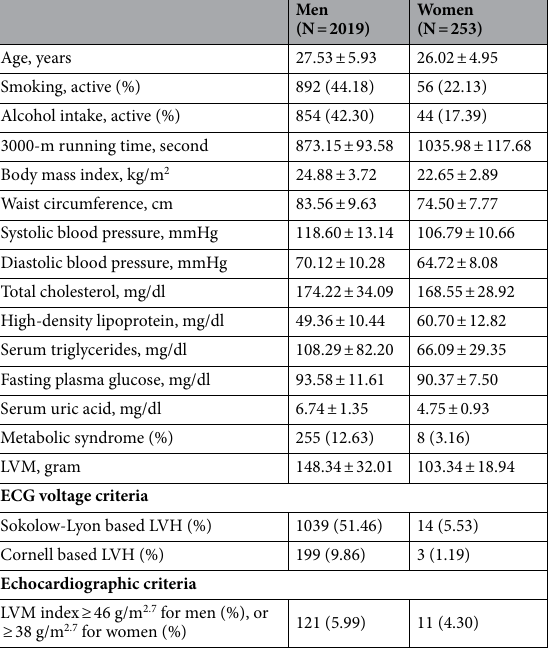
Table 1. Baseline Characteristics of the Military Men and Women (N = 2272. ECG Electrocardiography, LVH Left ventricular hypertrophy, LVM Left ventricular